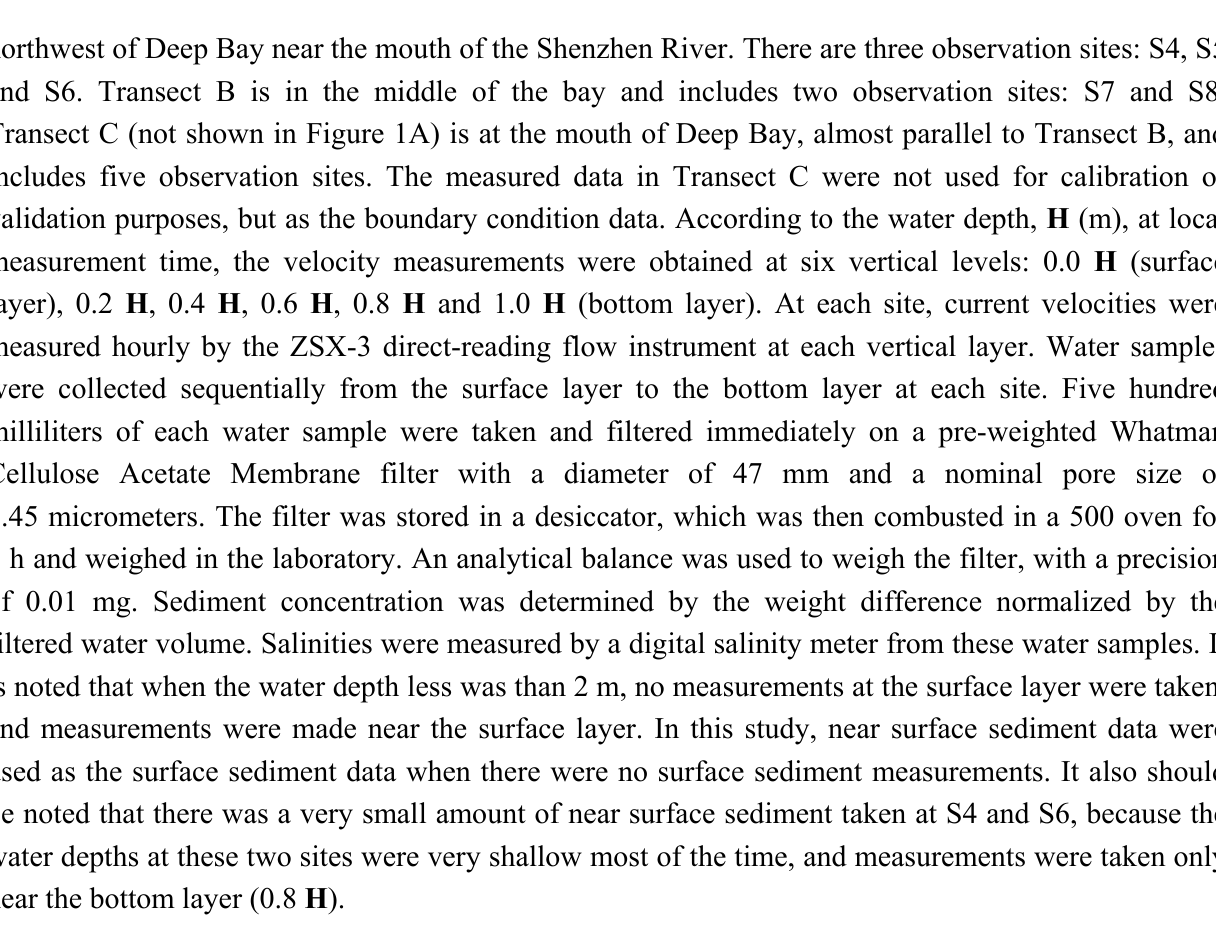
Figure 1. Model area and in situ measurements location ( A ) and the model grids with bathymetry ( B ). FNNR, Futian National Nature Reserve; MPNR, Mai Po Nature